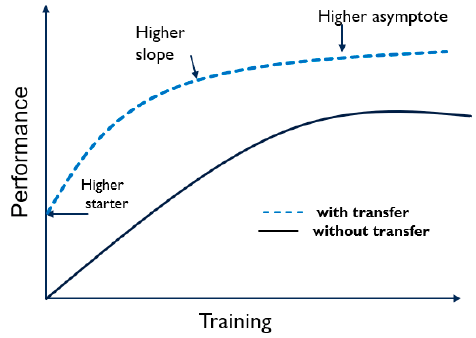
Figure 4. The benefits of transfer Figure 4. The bene fi ts of transfer learning.